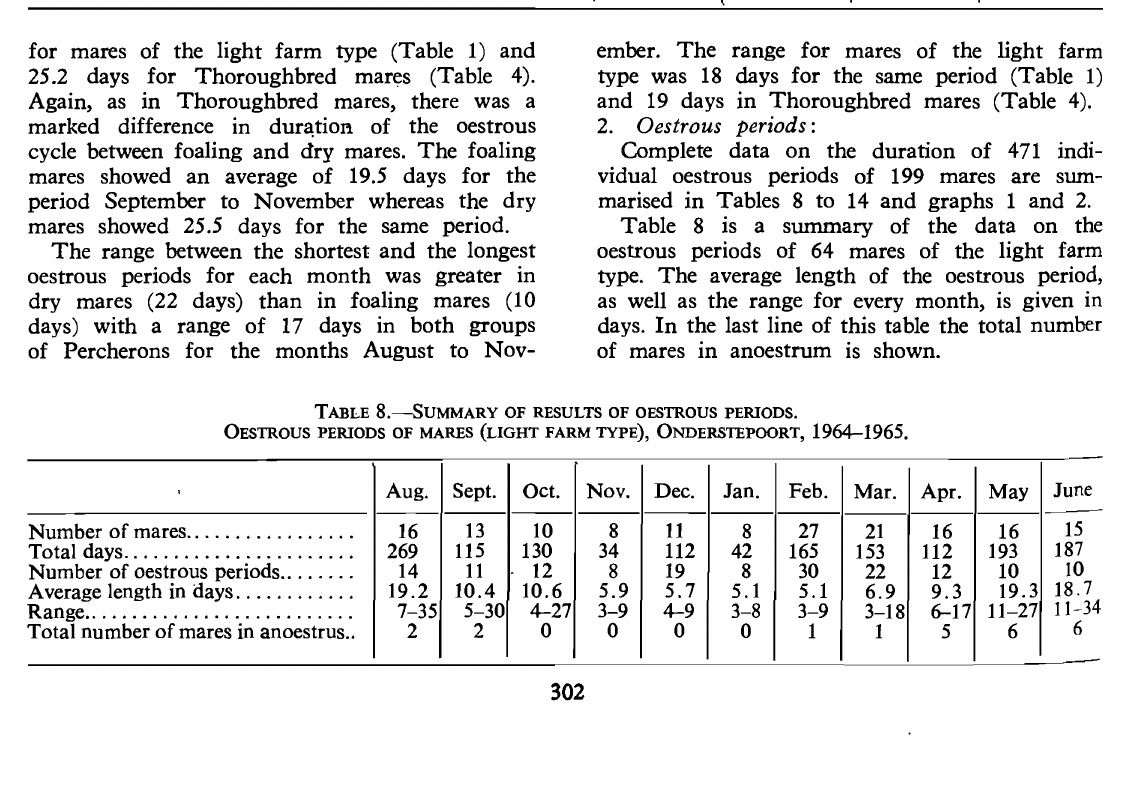
TABLE 7.--SUMMARY OF DATA OF BREEDING CYCLES. PERCHE,WNS: BARREN AND MAIDEN AND FOALING MARES, 1963. Aug. Sept. Oct.